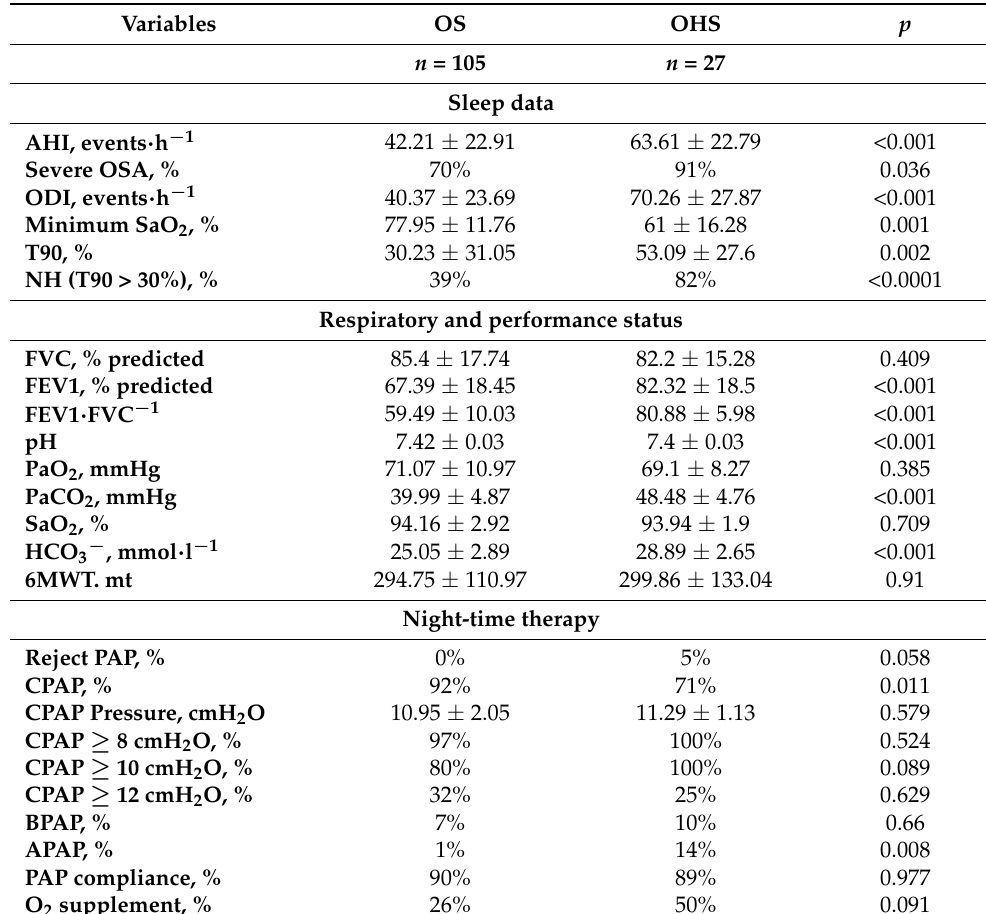
Figure 2. Comparison of sleep parameters between overlap syndrome (OS) and obesity hypoventi- lation syndrome (OHS): ( A ) apnea-hypopnea index (AHI), ( B ) oxygen desaturation index (ODI), ( C ) oxygen saturation (SaO 2 ) and ( D ) time in bed with SaO 2 <90% (T90). ** p < 0.001. Conversely, when assessing respiratory function, subjects with OS had a lower FEV 1 ( p < 0.0001) than the OHS.